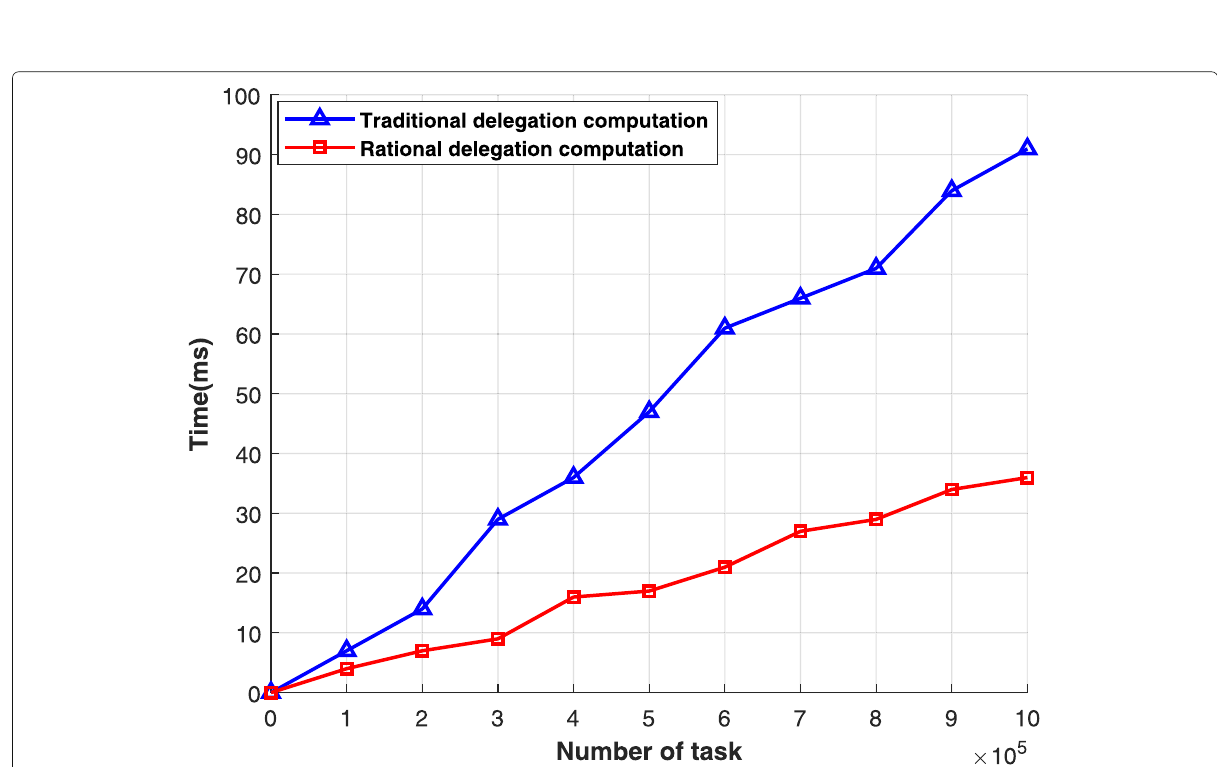
Fig. 4 Time cost of delegating